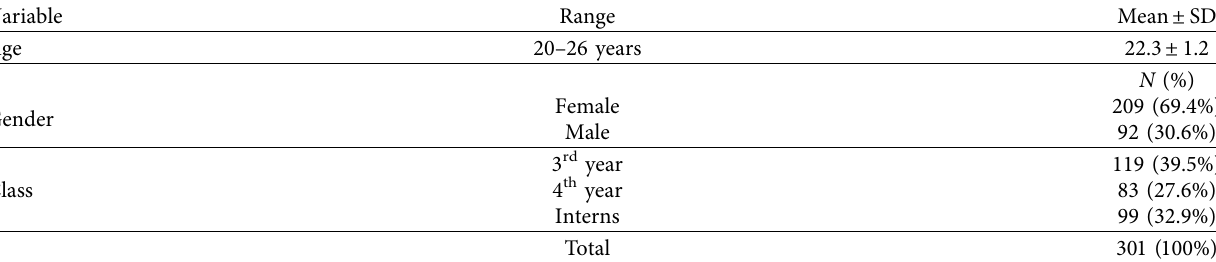
Table 1: Demographics of the study